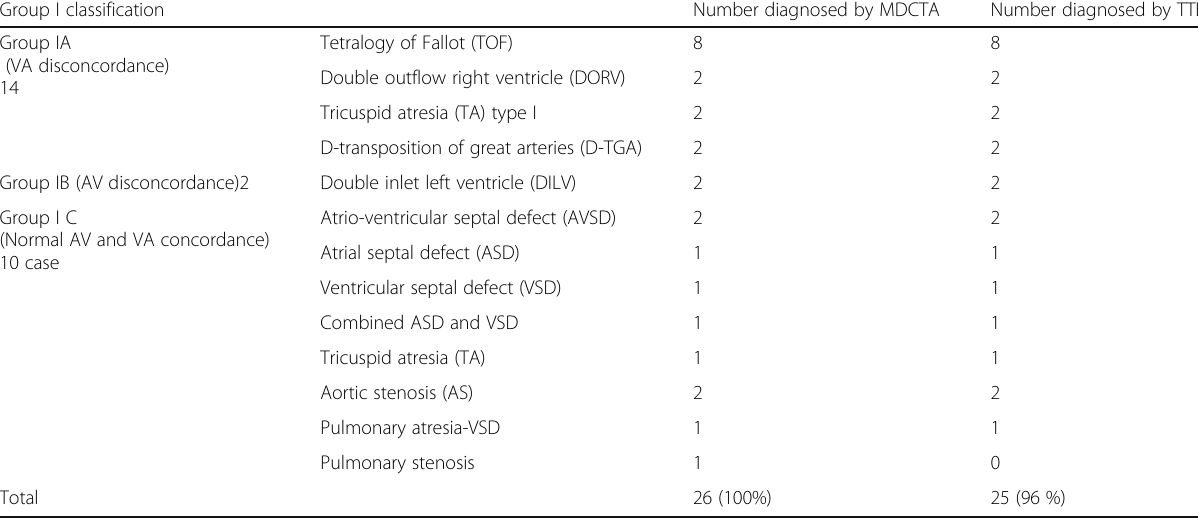
Table 1 Detection of cardiac anomalies in group I by MDCTA and TTE Group I classification Number diagnosed by MDCTA Number diagnosed by TTE Group IA (VA